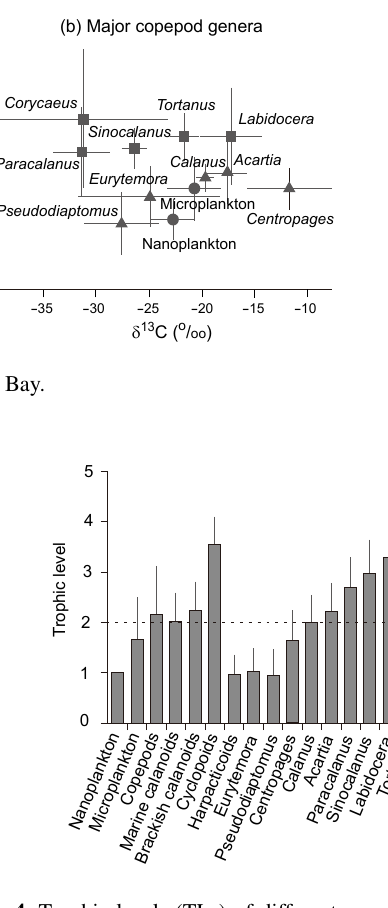
Figure 4. Trophic levels (TLs) of different groups. Nanoplankton were set as TL = 1, while consumers’ trophic levels were calcu- lated as TL = 1 + (δ 15 N consumer − δ 15 N Nanoplakton )/ 3. The refer- ence line indicates the herbivores relative to nanoplankton. How- ever, nanoplankton here might not be truly primary producers as the bulk samples might include heterotrophic flagellates, dinoflag- ellates, and ciliates, which we could not separate from the collected